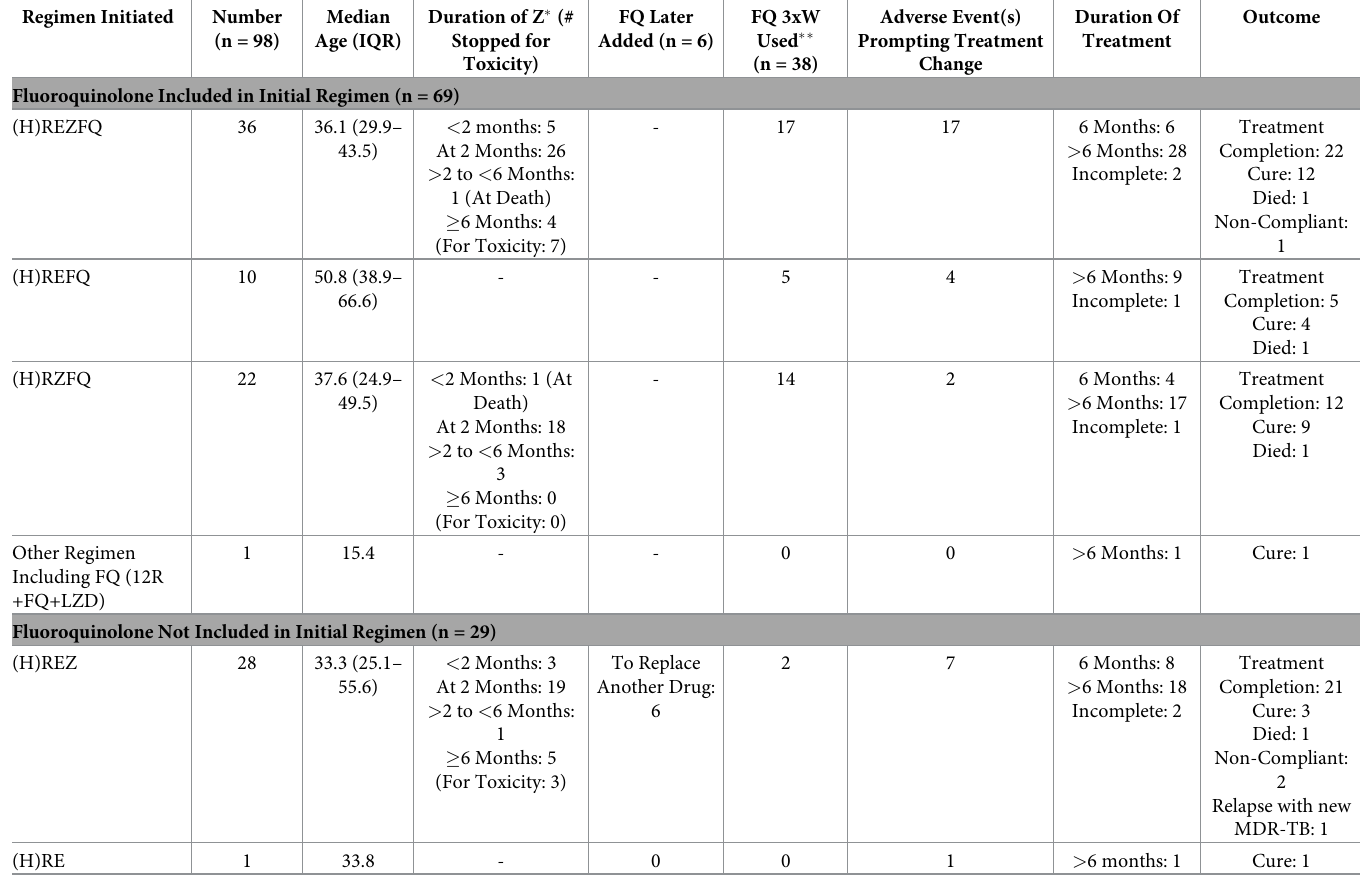
Table 1. Regimens utilized for Hr-TB and outcomes